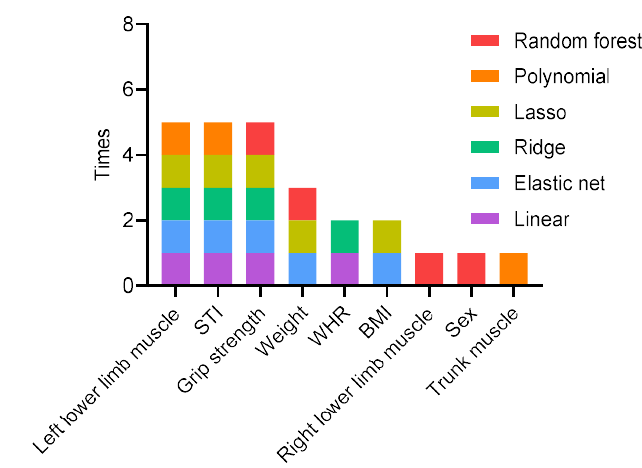
Figure 1. Features used when each model was iterated to the optimal.